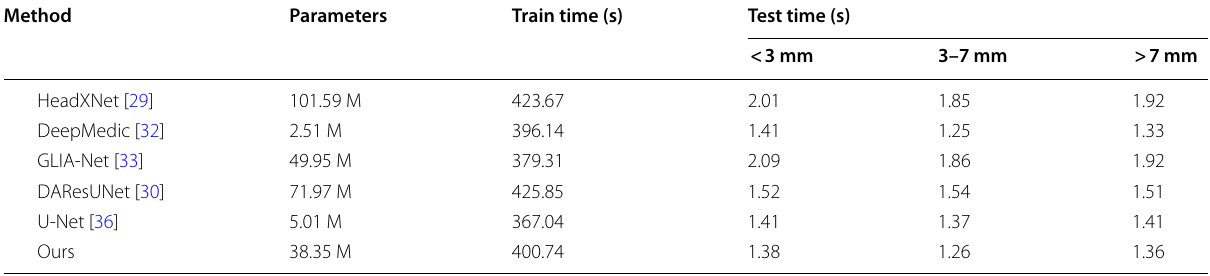
Table 7 Comparison of computational time and memory metrics, for the dataset of aneurysms supplied by the Affiliated Hospital of Qingdao